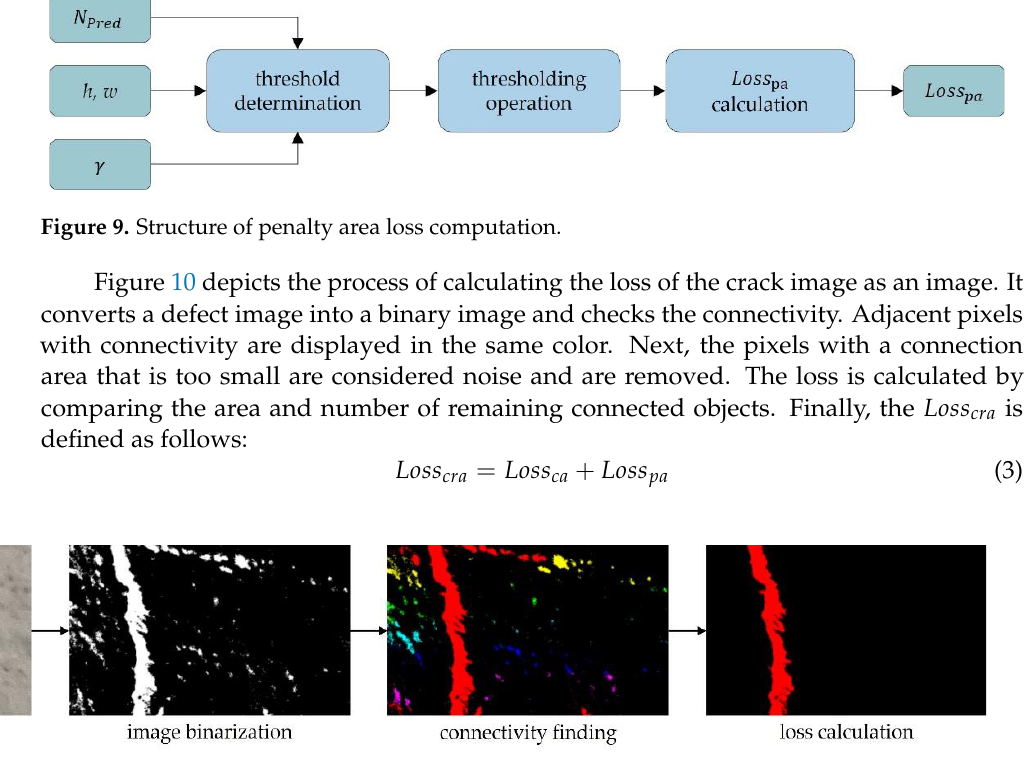
Figure 10. Processing example images of connectivity finding.